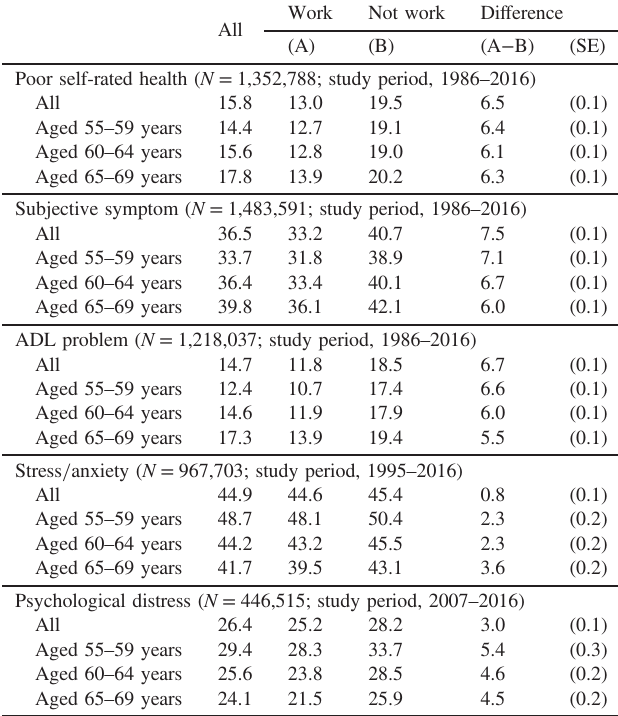
Table 2. Prevalence (%) of health outcomes by work status